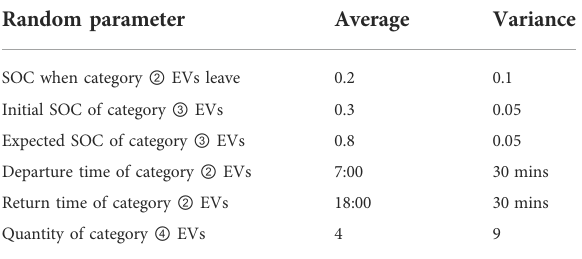
TABLE 2 Other related parameters of EV.